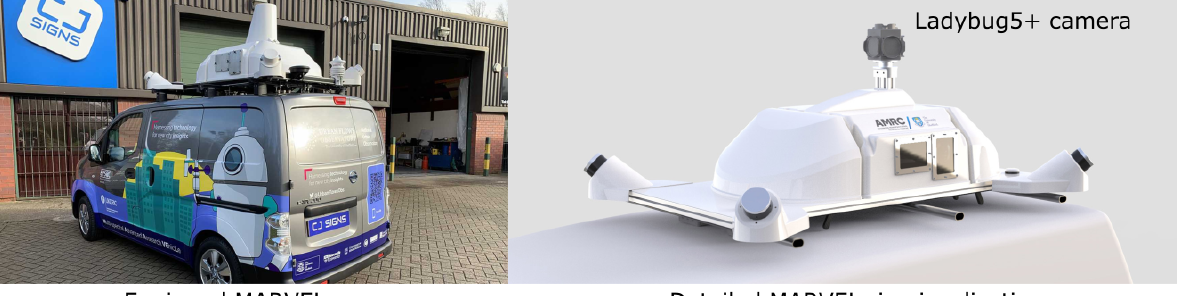
Figure 2. A demonstration figure of the data-capturing system used in this paper, MARVEL. The left-hand side shows the equipped data capturing platform. The integrated rig is mounted on top of an electric van. The right-hand side shows a detailed view of the multi-spectral sensors. The camera is installed on top of the rig to provide an unobstructed view. More detailed technical information on the data collection platform and equipped sensors can be found in